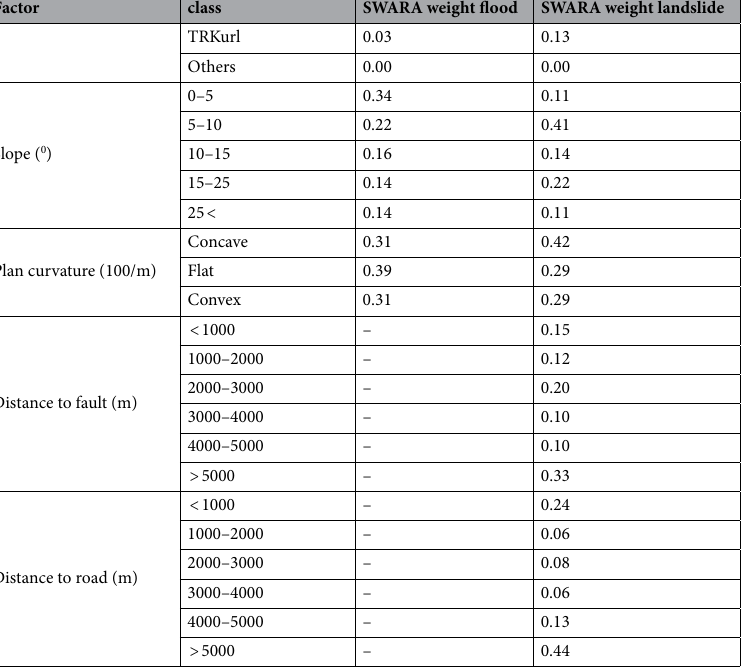
Table 3. SWARA weight for each influencing